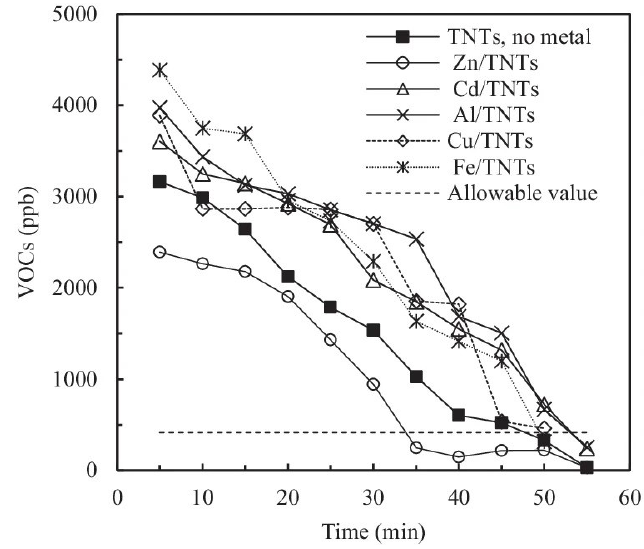
Figure 11. VOC degradation of different metal-doped titania nanotubes. (Reprinted/adapted with permission from Ref. [88]).